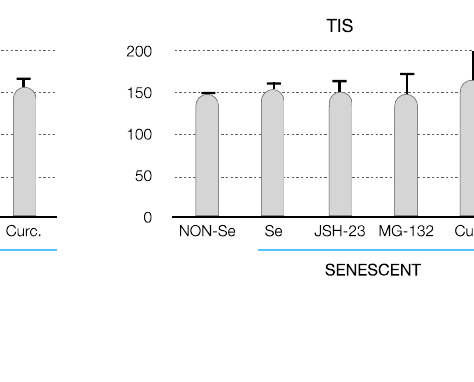
Figure 7. Inhibition of the p65 pathway in cellular senescence and proinflammatory activation in MSCs prevents the release of small extracellular vesicles (sEV). ( A ) Size distribution of sEV from MSCs treated with JSH-23, MG-132 and curcumin during the induction of cellular senescence models (DDIS and TIS) and ( B ) proinflammatory activation (PA) using a nanoparticle tracking analysis (NTA). Data shown the mean ± SD of three independent experiments. Nonparametric Kolmogorov – Smirnov test was used to calculate the significance, and it was represented as p < 0.05 and p < 0.01. Quantification of the number of particles in ( C ) MSCs treated with JSH-23, MG-132 and curcumin during the cellular senescence induction (DDIS and TIS) and ( D ) PA using an NTA. The graphs shown the mean ± SD of three independent experiments. Nonparametric Kolmogorov – Smirnov test was used to calculate the significance, and it was represented as